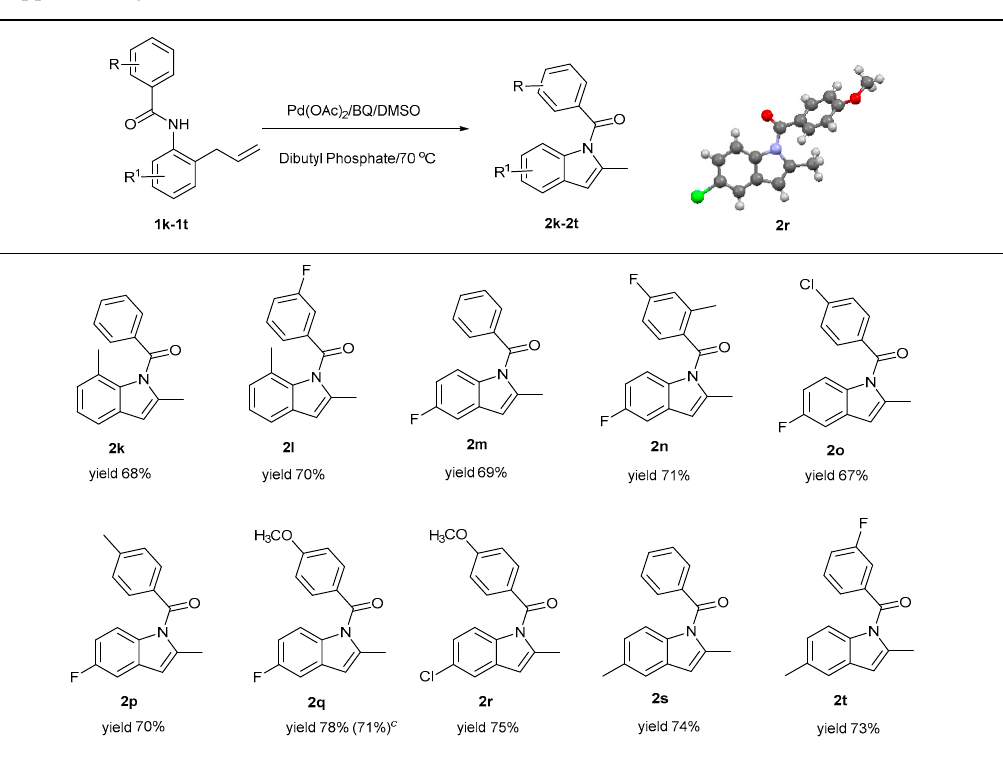
Table 3. Substrate scope of substrates with substituents at the positions (R 1 ) a,b Conditions: See